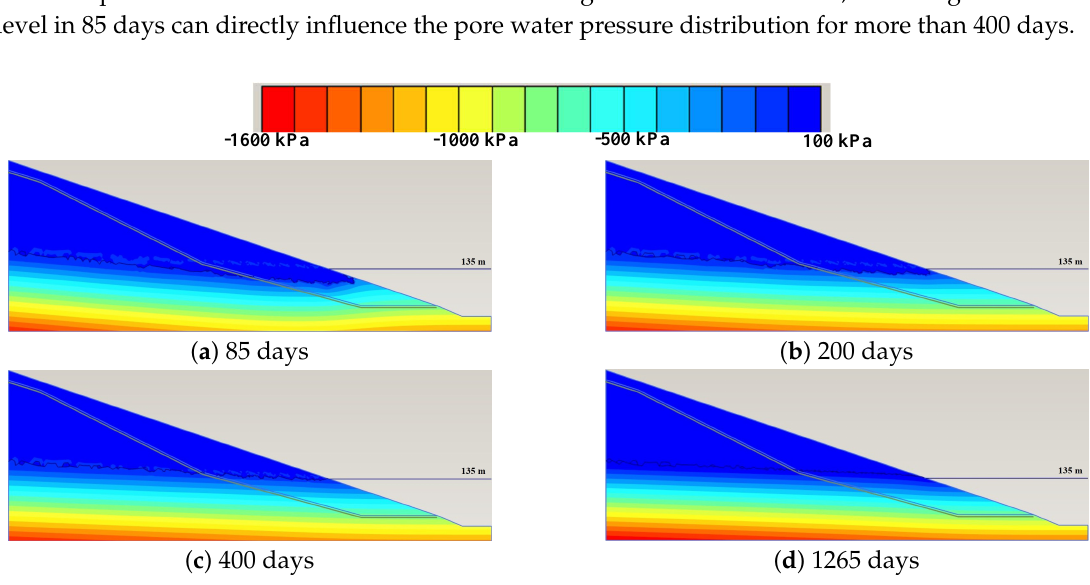
Figure 4. Pore water pressure evolution at different time steps after the river level starts